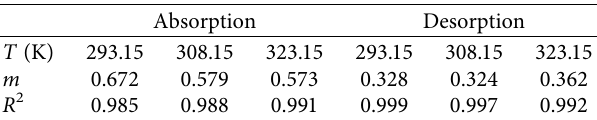
Table 5: m values corresponding to the absorption and desorption process.